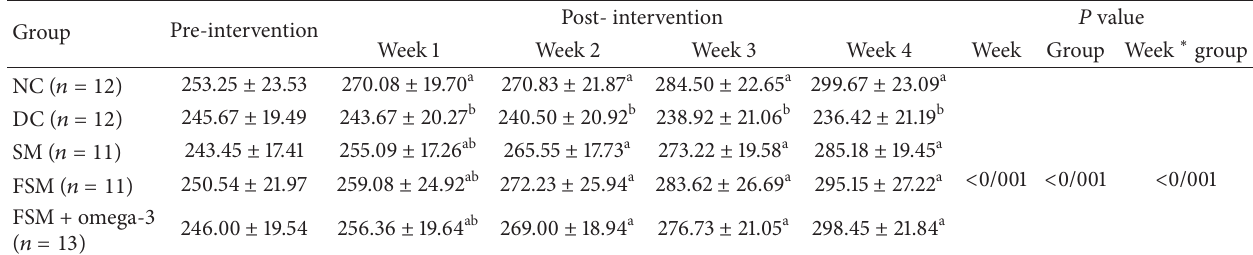
Table 2: Body weights change of each group fed with different products.